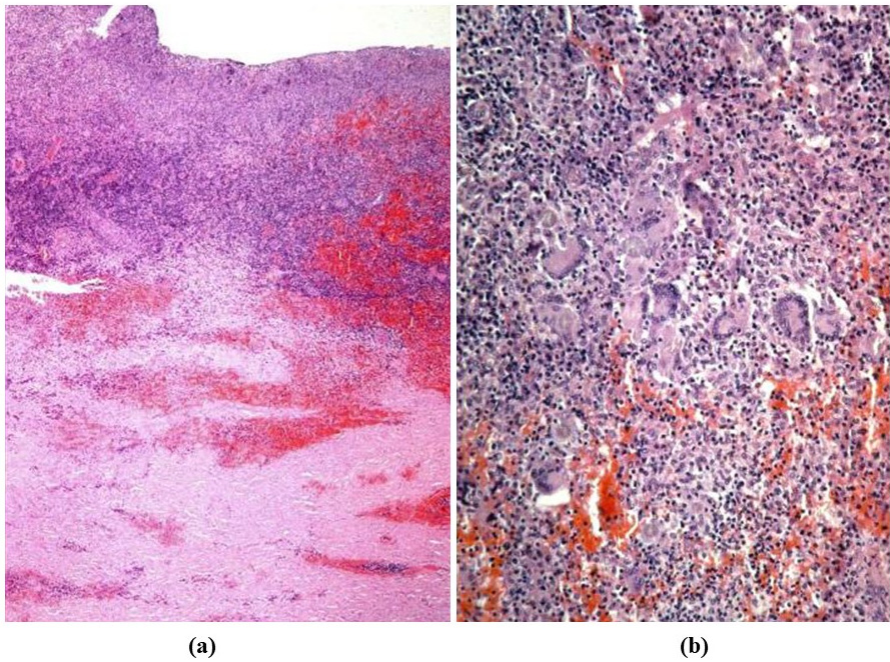
Figure 25. Giant cell aortitis with massive inflammatory disease: ( a ) panoramic view; ( b ) high-power view: note the giant cells (hematoxylin-eosin stain).